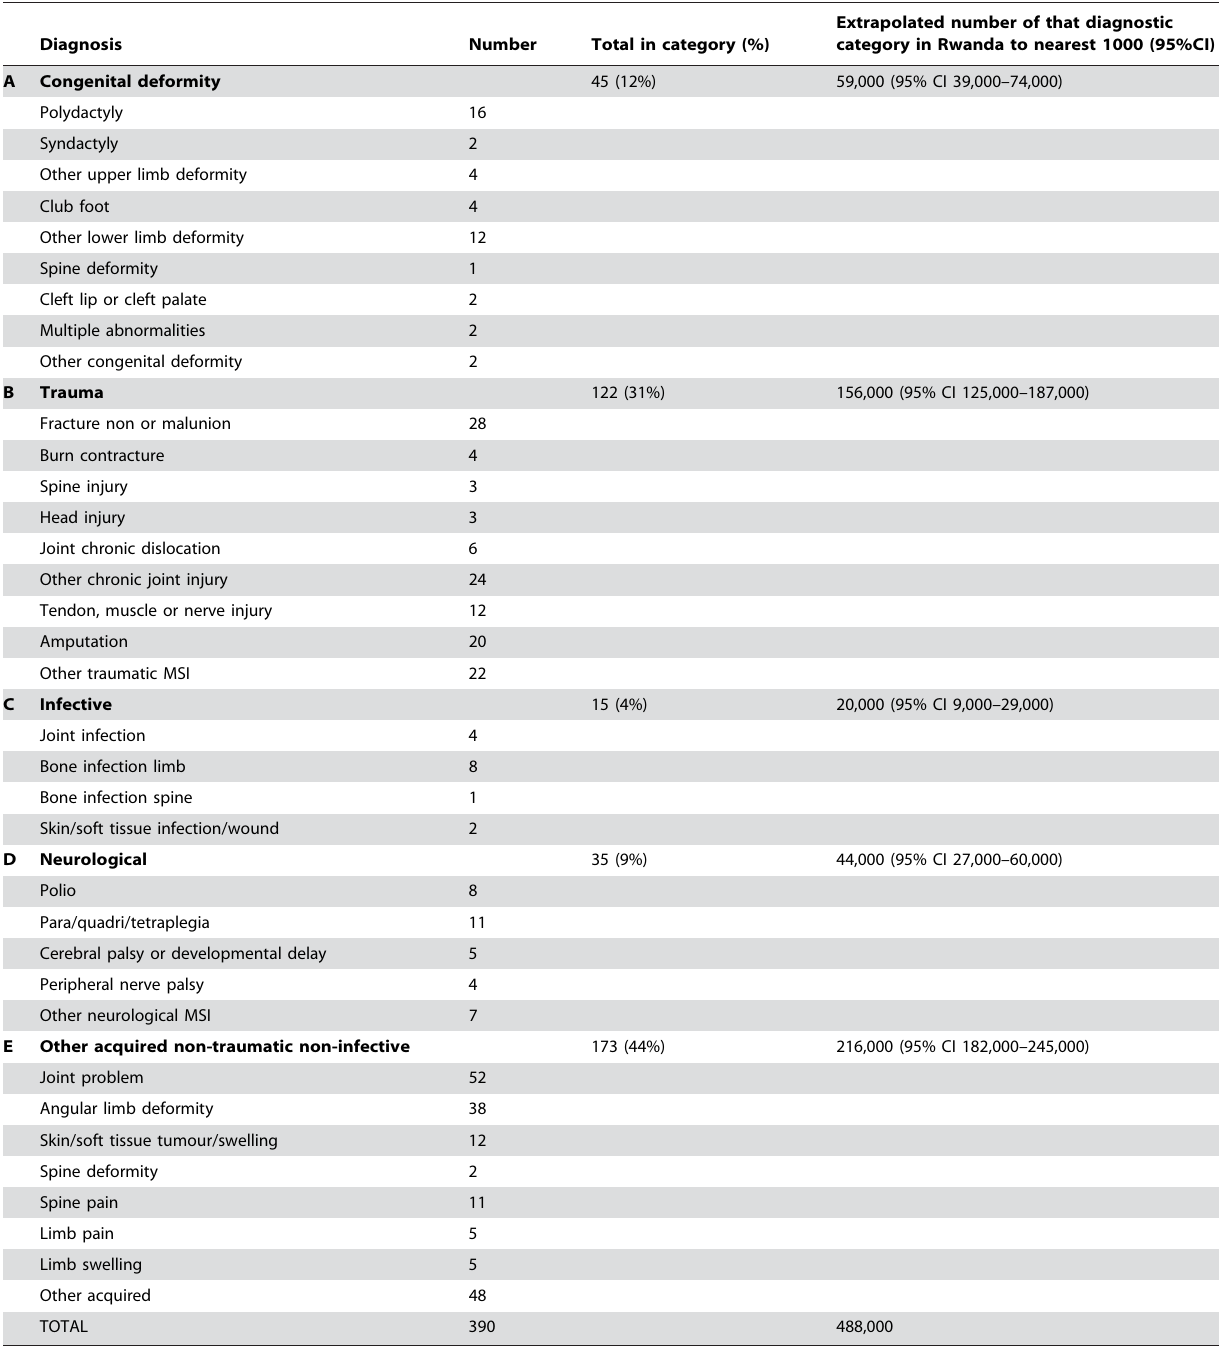
Table 4. Cause of MSI in survey, and extrapolated to population of